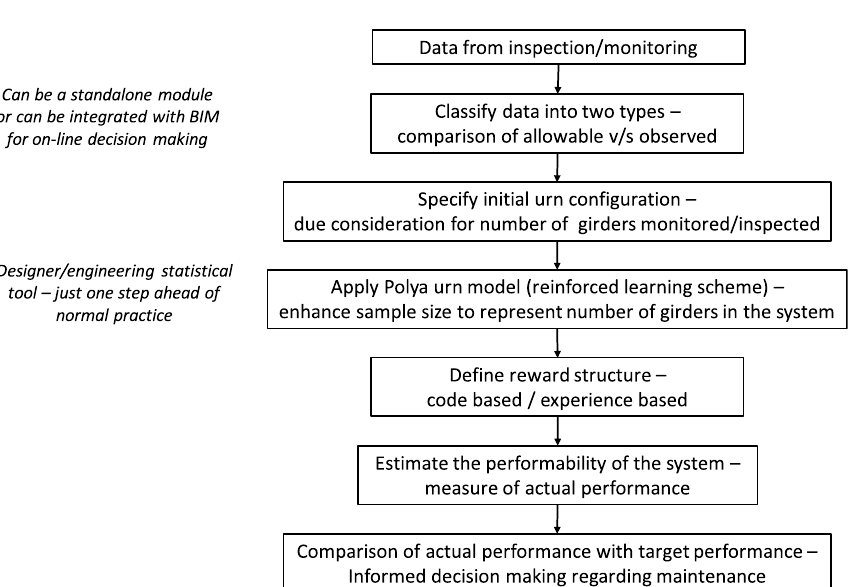
Fig. 1 Schematic representation of the Poly urn model-based procedure for performance assessment of bridge system